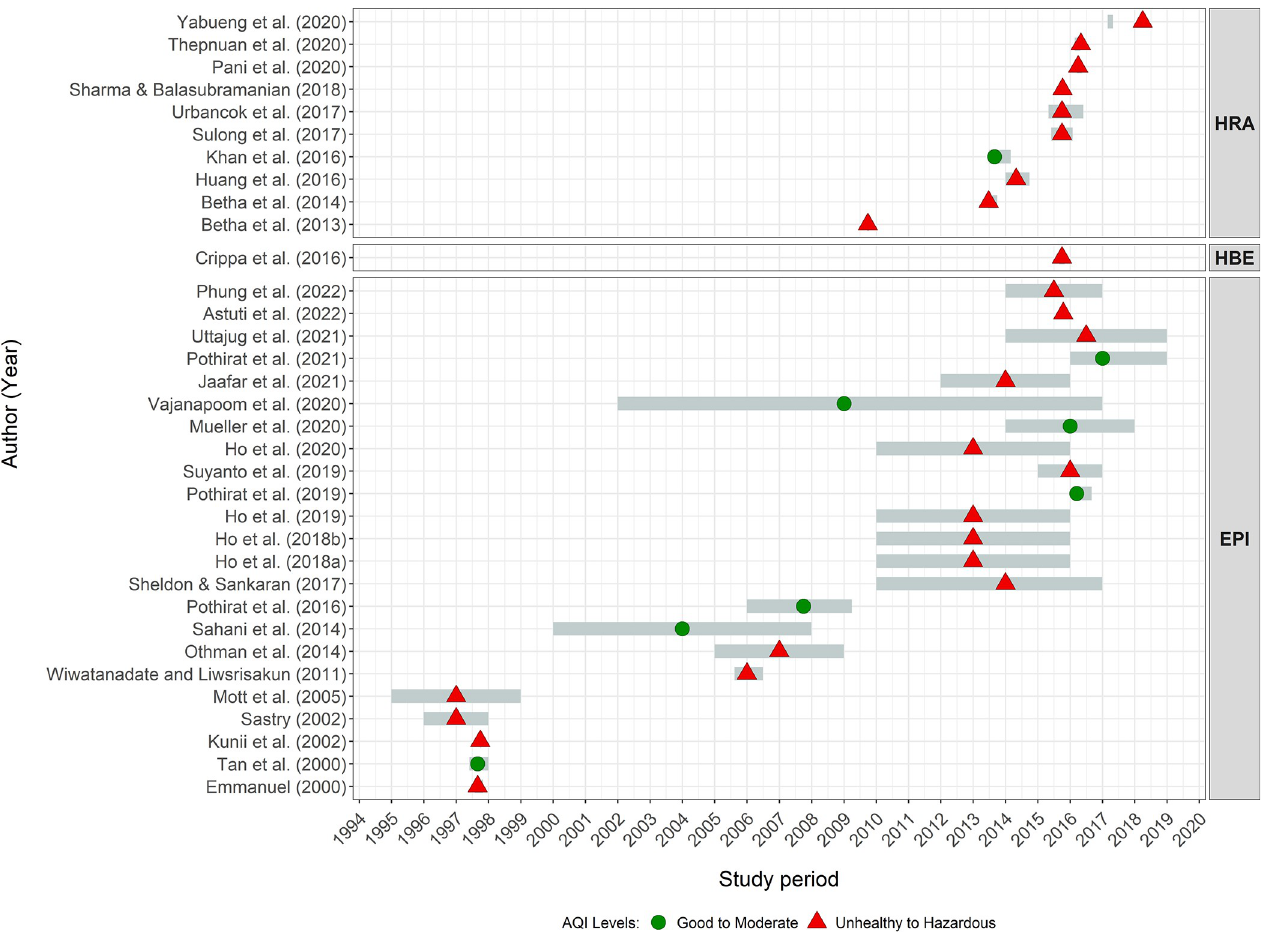
Fig 6. AQI levels by study period and study